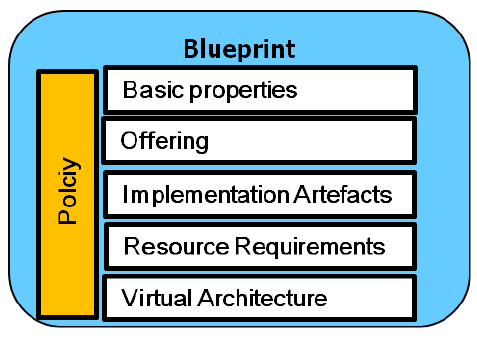
Figure 3. Fundamental Blueprint